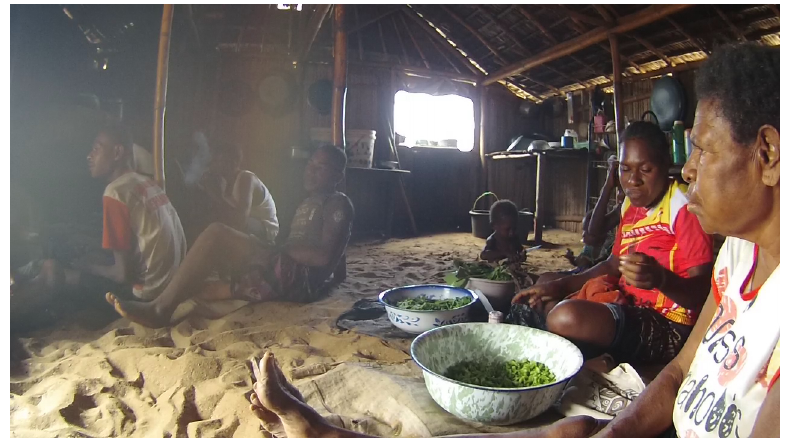
Figure 7: ‘Kolum and Tayon are searching each other for lice.’; cf. example (14)